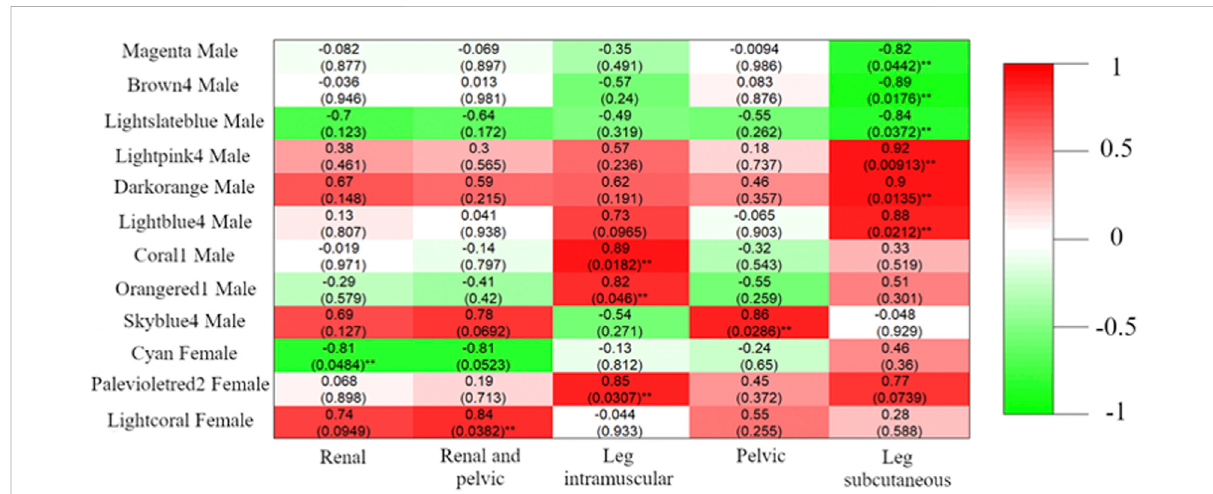
FIGURE 6 Pearson correlation between module eigengenes and fat percentage in different adipose deposits (Renal, Pelvic, Renal and Pelvic, Leg subcutaneous, and Leg intramuscular). The modules shown in the fi gure are the differentially coxpressed modules harboring at least one of the 314 discriminant genes between males and females. For each module, after the color identi fi cation of the module, it is indicated if the coexpressed gene module was identi fi ed in males or females. The Pearsoncorrelation between thefat percentage and the module is shown in the fi gurefor each speci fi c fat deposit, and the p -value assigned for each correlation coef fi cient is shown between parenthesis (** p -value < 0.05). The color scale represents the signal of the correlation coef fi cient, where green shades represent negative correlations and red shades positive